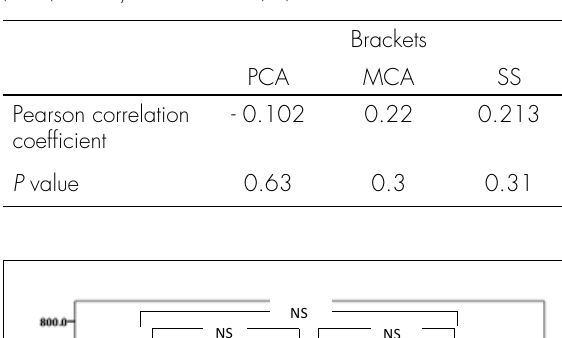
Table V. Correlation between frictional resistance and root mean square (Sq) parameter of the bracket types. (PCA) polycrystalline alumina. (MCA) monocrystalline alumina. (SS) stainless steel.